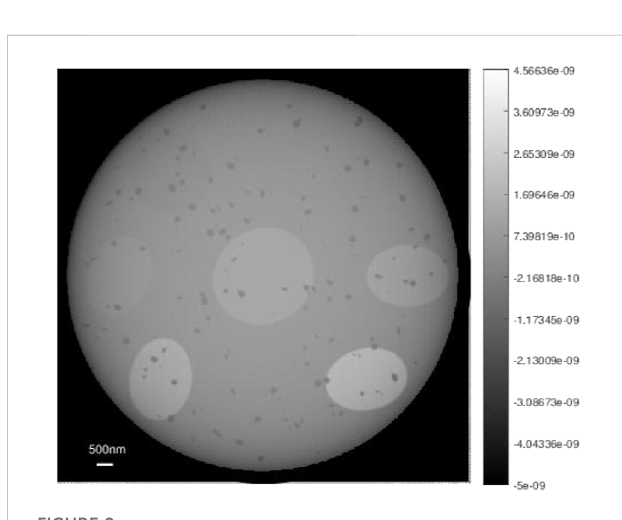
FIGURE 9 The inversion result using LSM for noisy data with noise-level 0.1%.